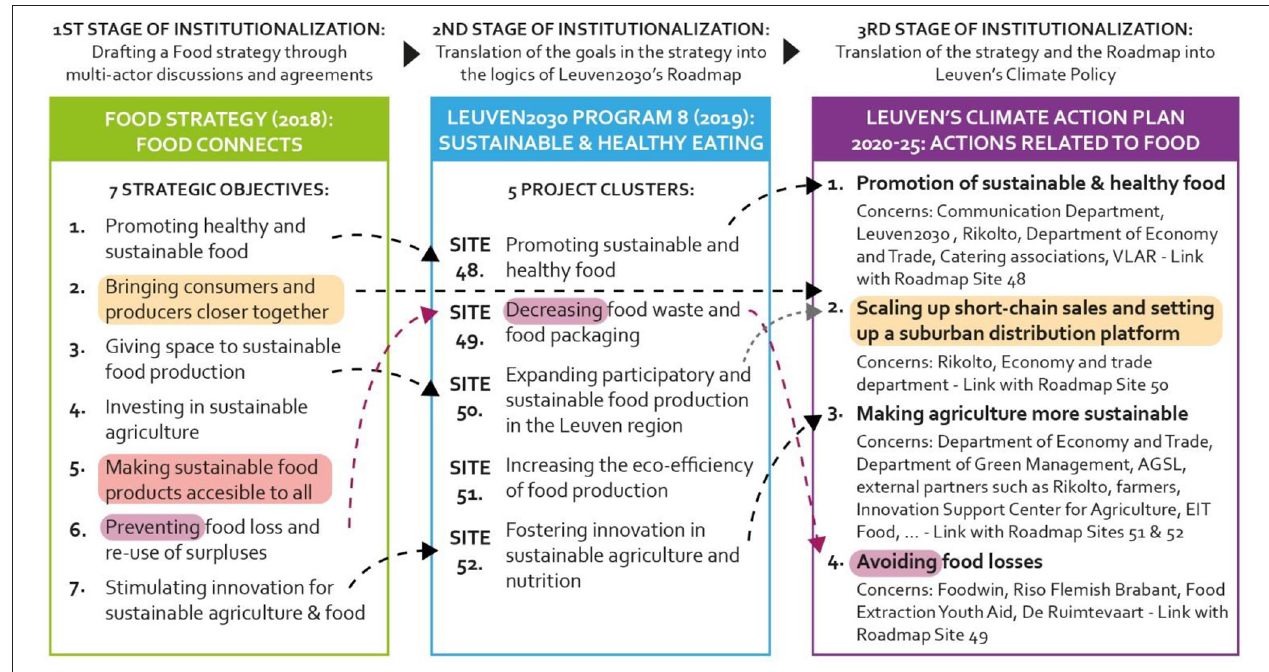
FIGURE 9 | Analysis of the evolution of the objectives of the Food Strategy along its institutionalization